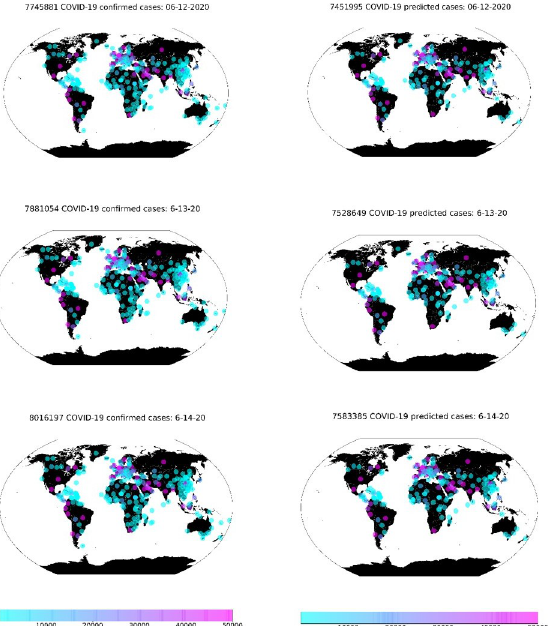
Fig 9. Accumulated confirmed cases (left-hand side) vs predicted ones globally (right-hand side) for the last three days of the examined data (the period between 12/06/2020 to